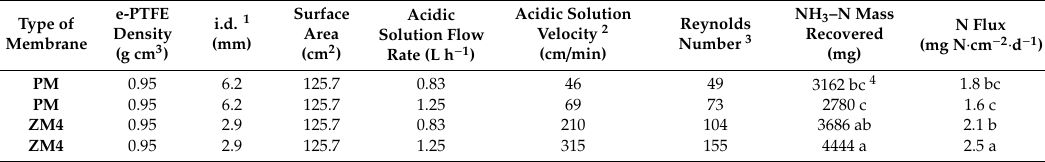
Table 4. E ff ect of acidic solution velocity on NH 3 –N recovered and N-flux of gas–permeable membranes (experiment 2).